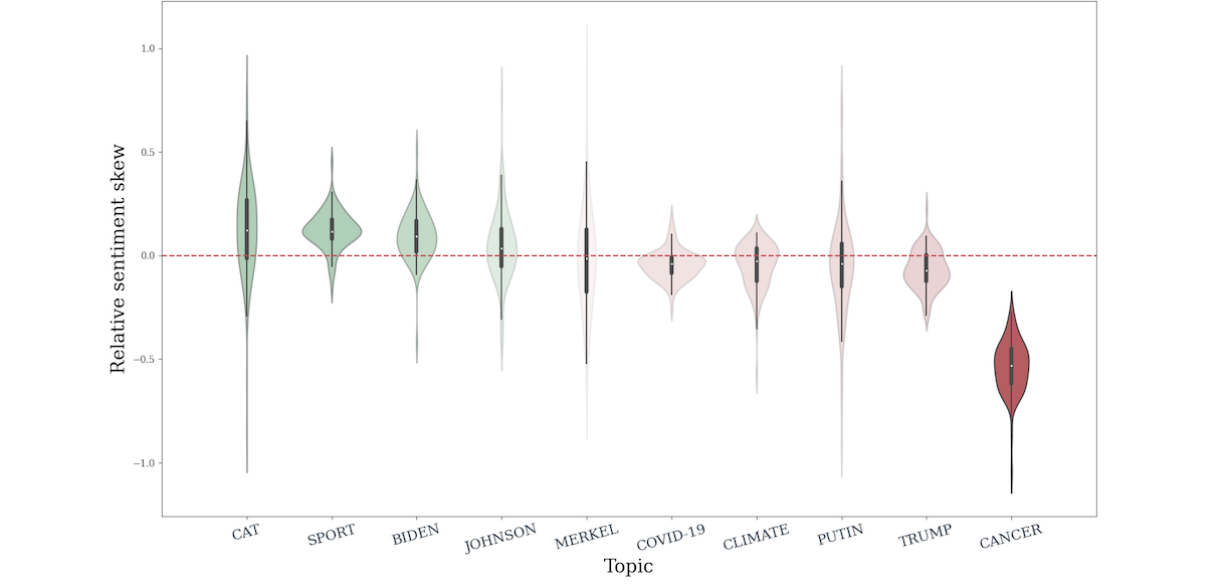
Figure 2. Relative sentiment skew ( rrskew ) of COVID-19 coverage. Each article title and description from each English-language online news source (ONS) received a Vader sentiment compound score between –1 and 1 (most negative and most positive, respectively). We noted the difference in mean sentiment for a specific topic and mean sentiment for other 2020 articles in a given online news source ( rsskew ONS,TOPIC ; see Methods section). The density of the relative sentiment skew is plotted for each topic. Distributions are colored green if their relative sentiment skew was predominantly positive or red if predominantly negative (Table 4). Intensity of the color is scaled by the distance from the red dotted line at 0, which indicates a lack of difference between topic sentiment and all other articles in a given online news